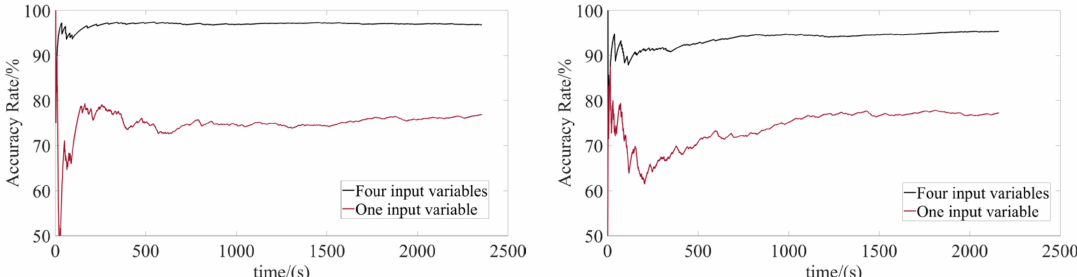
Figure 5. Identification results under simulation (( left ): mild, ( right ):